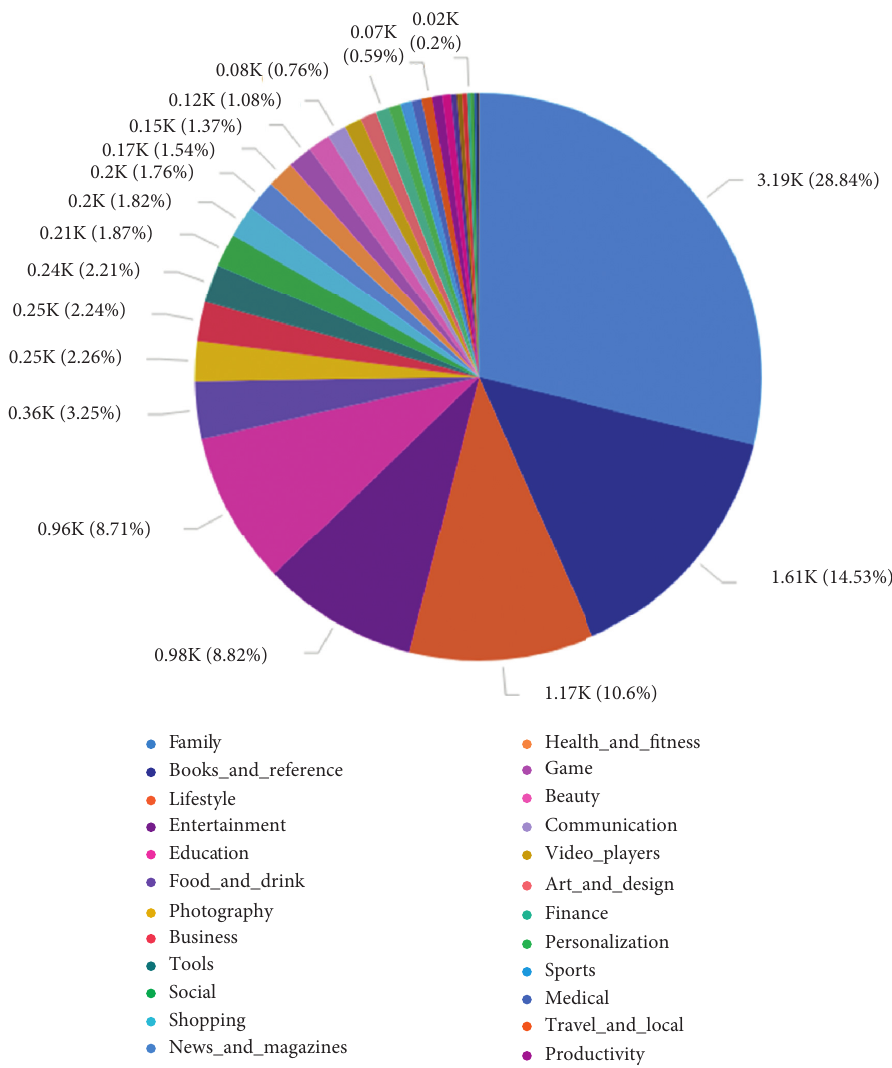
Figure 3: Number of Arabic apps per category in Google Play app